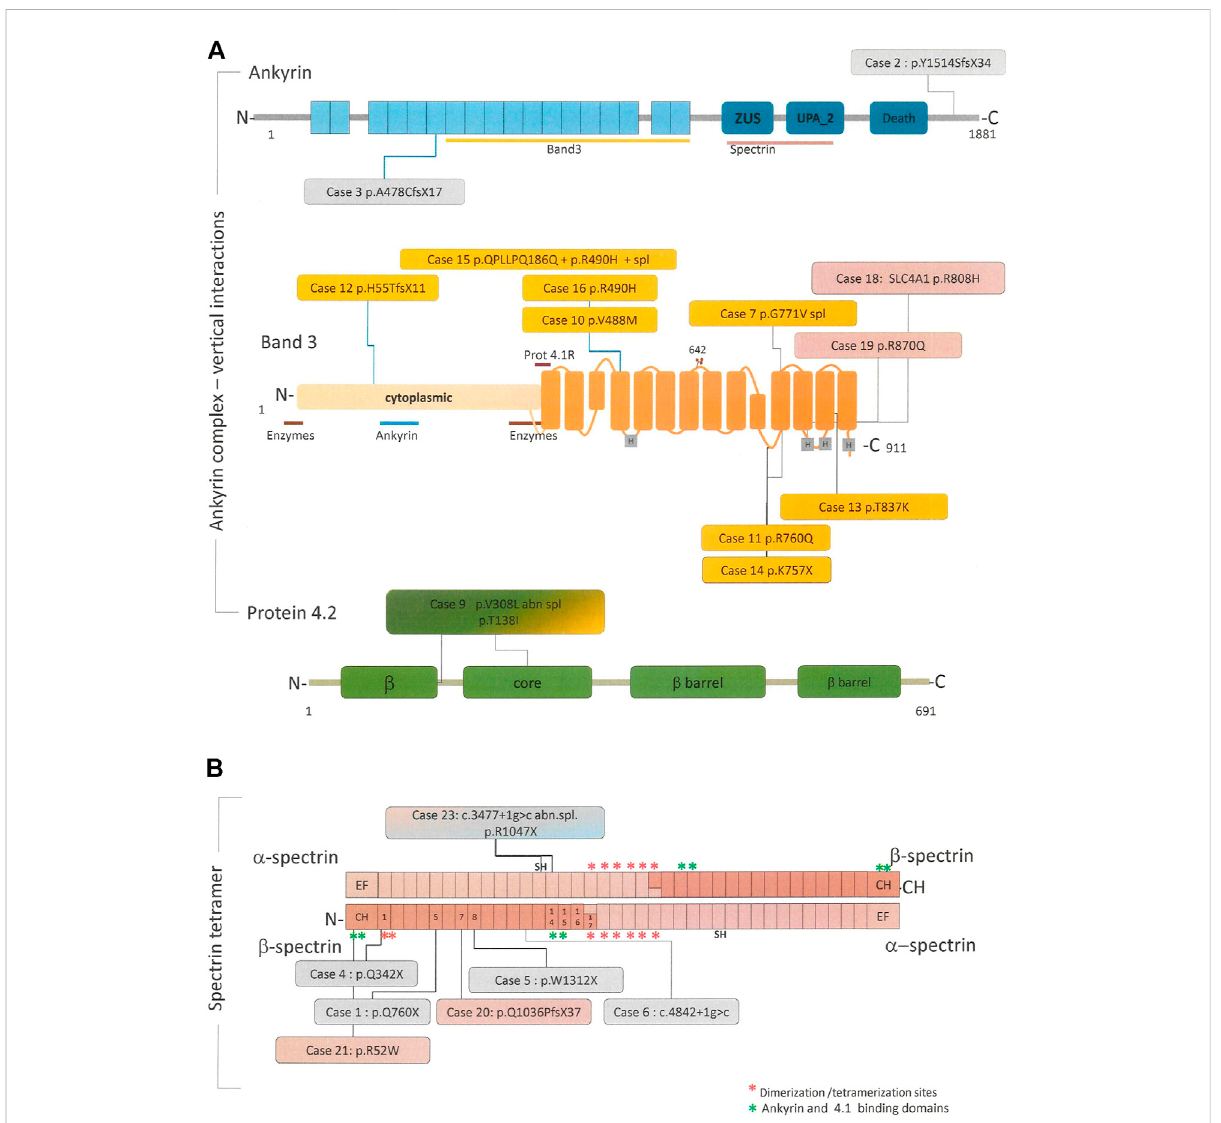
FIGURE 1 Linear schematic representation of the main proteins involved in the pathogenesis of HS, in particular ankyrin, band 4.2 and band 3 forming the “ ankyrin complex “ (A) and the alpha and beta spectrin tetramer (B) . When available, binding site for other cytoskeletal proteins or RBC enzyme are reportedalongtheproteins.Allthepathogenicvariantsidenti fi edinthisstudyandtheirpositionintherespectiveproteinsarereportedinthecolored boxes.Boxescolorscorrespondtotheproteinde fi ciencyidenti fi